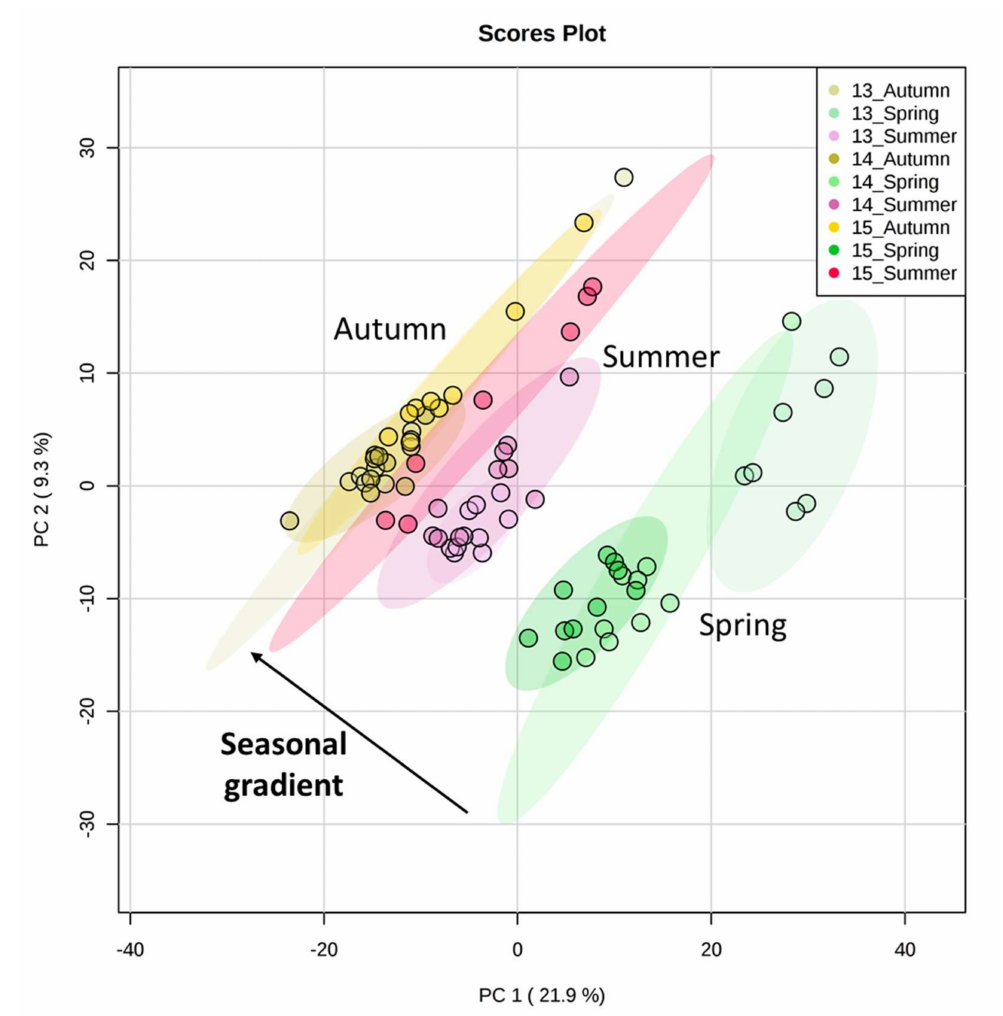
Figure 2. Principal component analyses (PCA) on metabolic fingerprints (untargeted analyses) according to years and seasons. The drought treatments were merged for this